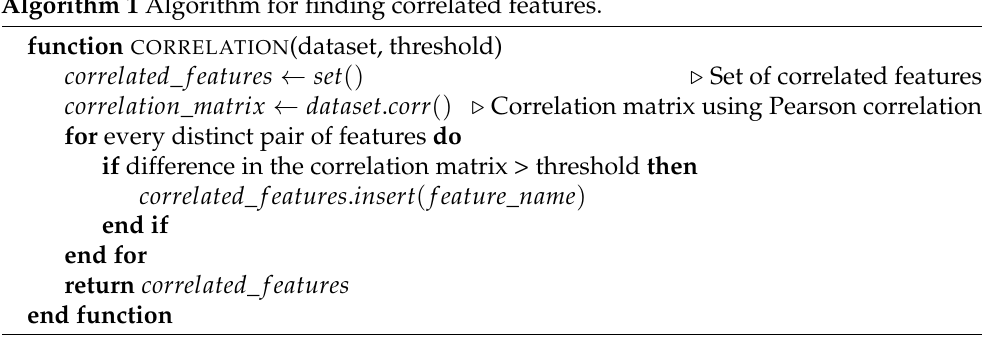
Algorithm 1 Algorithm for finding correlated